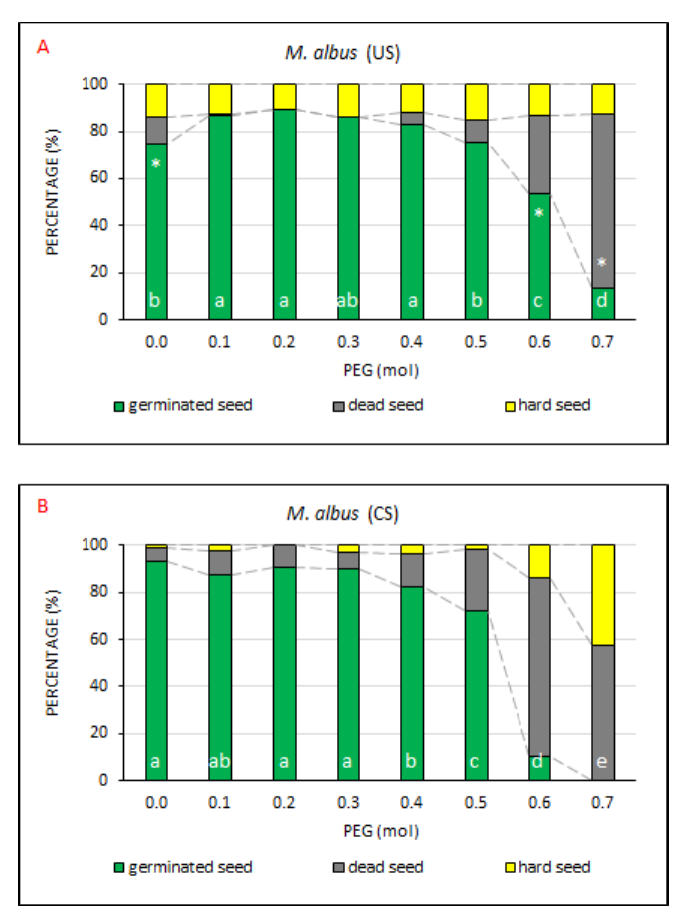
Figure 9. The comparison of germinated, dead and hard seed percentages at drought simulation degrees. Average percentages of GS, DS and HS for M. albus , the ( A ) US (uncoated seeds; n = 4 ± SE) and ( B ) CS (coated seeds; n = 4 ± SE) treatments at the respective PEG concentrations = 0.0 – 0.7 mol. Different lowercase letters indicate a significant difference (ANOVA post-hoc Tukey´s HSD test; p < 0.05) between the percentages of GS values in the US and CS treatments. The * symbol represents a significant difference in the percentages of GS values between US and CS at a specific PEG concentration.